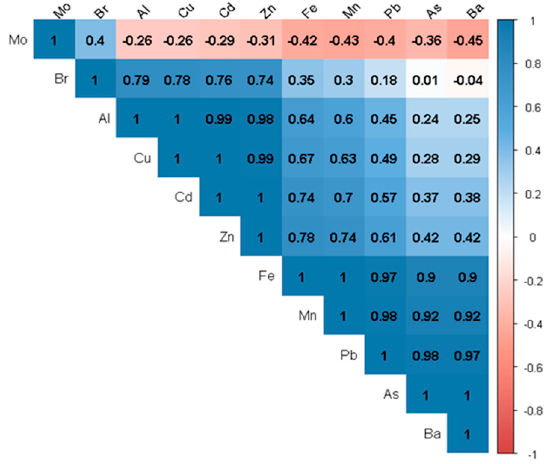
Figure 7. Groundwater correlation matrix.